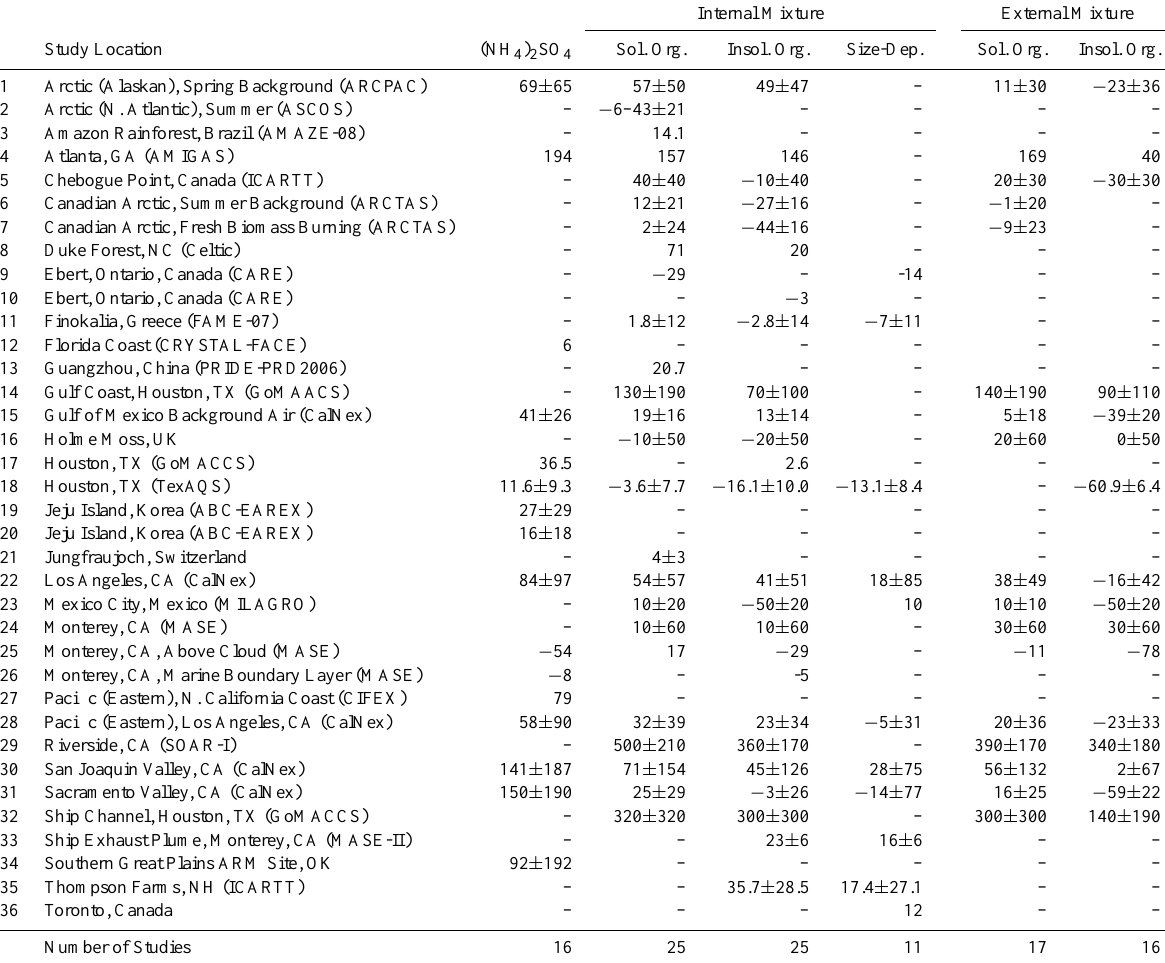
Table 2. CCN number concentration percent overprediction ( 1N CCN /N CCN ) × 100% for different closure scenarios reported by the studies in Table